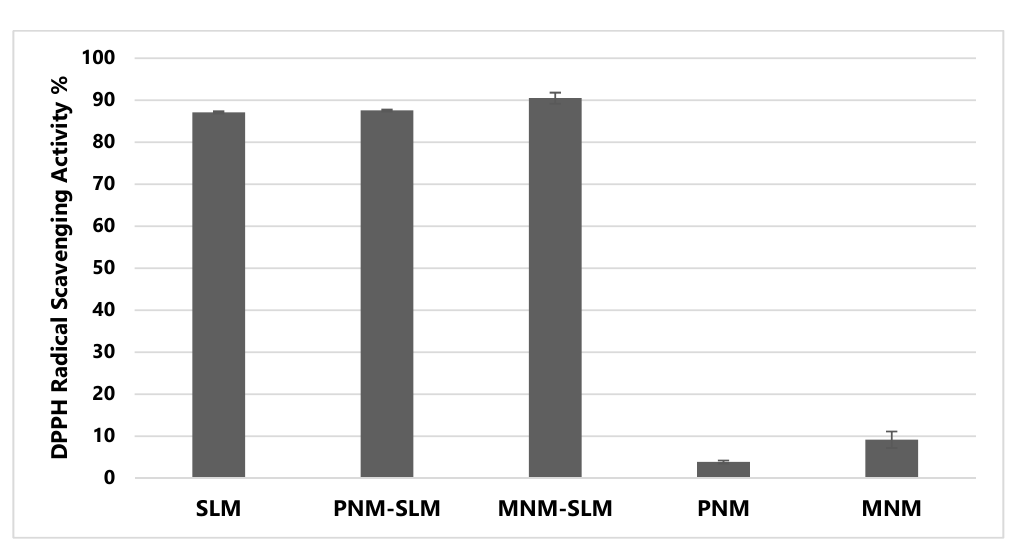
Figure 7. Antioxidant activity of SLM in solution, SLM-loaded polymeric nanomicelles (SLM-PNM), SLM-loaded mixed nanomicelles (SLM-MNM), empty polymeric nanomicelles (PNM) and empty mixed nanomicelles (MNM) (Mean ± SD, n = 3).